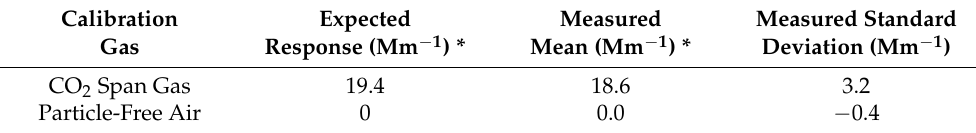
Table 1. Nephelometer calibration data (n = 3 calibrations before, during, and after the sampling